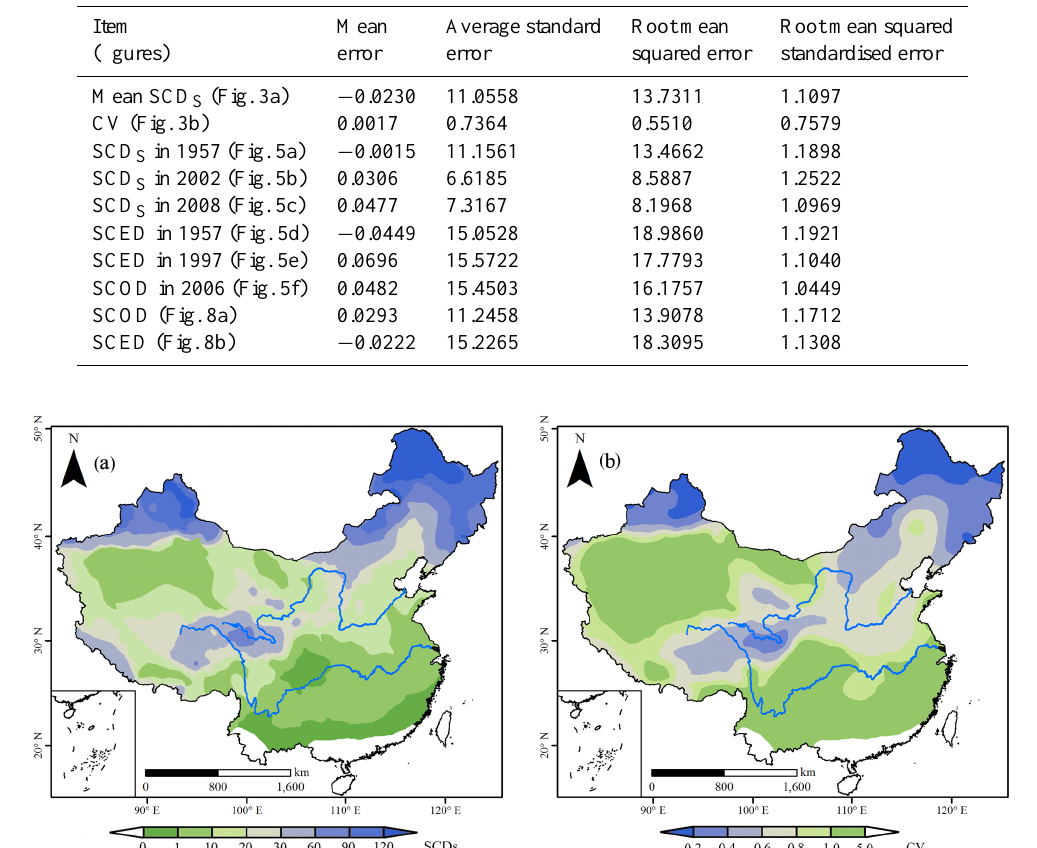
Table 1. Prediction errors of cross-validation for the spatial interpolation with the ordinary Kriging method (the unit is day for snow cover